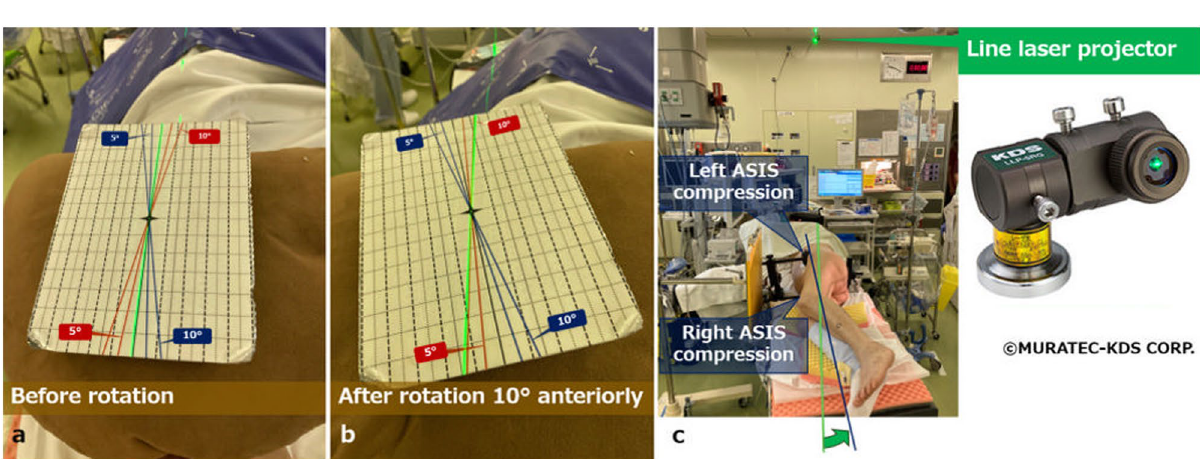
Figure 3. ( a ) Before operating table rotation. The patient is in the right lateral decubitus position. ( b ) The operating table was rotated 10° anteriorly, in this case, to adjust the pelvis tilt. A green laser beam can serve as an angular guide. ( c ) The pelvic tilt was adjusted by rotating the operating table guided by a green laser beam. A line laser projector is fixed on the ceiling of the operating room. Our pelvic lateral positioner can control the compression of the left or right anterior superior iliac spine (ASIS) independently to adjust the anterior or posterior pelvic